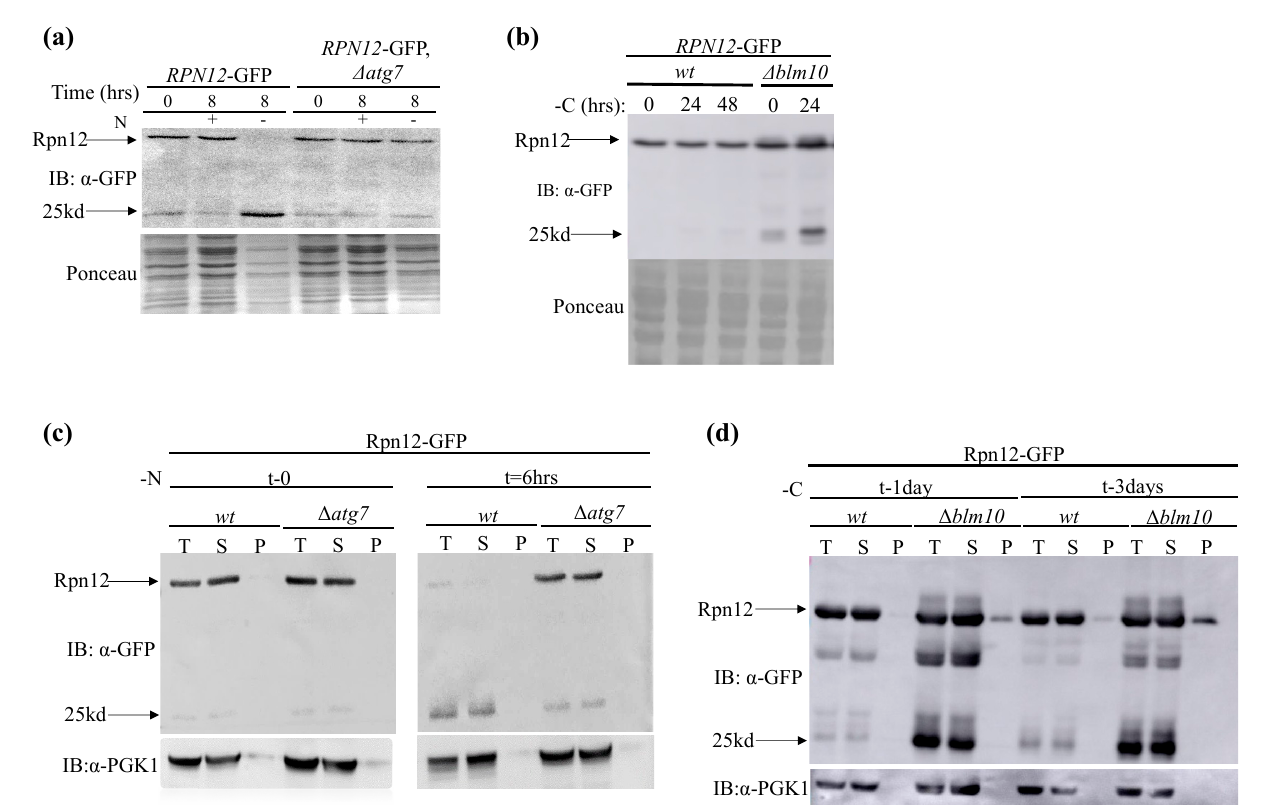
Figure 1. ( a ) Proteasomes in cells grown under nitrogen ( a ) and carbon starvation (in Δ blm10 cells) ( b ) are subjected to autophagy. ( a ) Logarithmically growing wt cells carrying RPN12 -GFP and deleted in the control autophagic pathway genes ( ∆ atg7 ) were grown in a rich medium (t-0). Cells were then washed with sterile water, resuspended in a minimal medium lacking nitrogen (-N), and allowed to grow for 8 h (t-8). ( b ) Similarly, to A, but the indicated logarithmically growing cells (in rich medium) (t-0) were re-suspended in carbon-free medium (-C) to induce carbon starvation for 24, or 48 hrs. Release of free-GFP from the Rpn12-GFP autophagy reporter was assayed by immunoblot analysis of total extracts with anti-GFP antibodies. Total protein Ponceau staining was used as the loading control. ( c , d ) Proteasomes confined in the soluble fraction of the cells are subjected to autophagy in response to nitrogen ( c ) , and carbon ( d ) starvation. Protein extracts from the cells described in A and B were subjected to detergent solubility assay (see Section 2), and total cell lysate (T), soluble (S), and insoluble pellet fractions (P) were immunoblotted with anti-GFP antibodies to detect Rpn12-GFP distribution and the free-GFP signal. Unless indicated otherwise, in all the free-GFP, and solubility assays, ponceau staining, and anti-Pgk1 served as a loading control, or a to normalize the soluble fraction, respectively. The intact Rpn12-GFP and the free-GFP proteaphagy reporters are indicated by arrows showing the 57 Kd and 25 Kd bands,